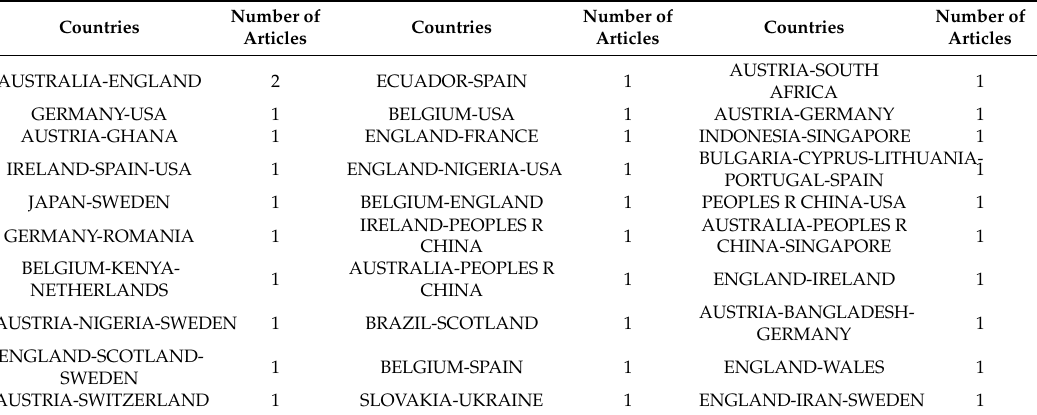
Table A3. Research with author’s addresses in at least two di ff erent